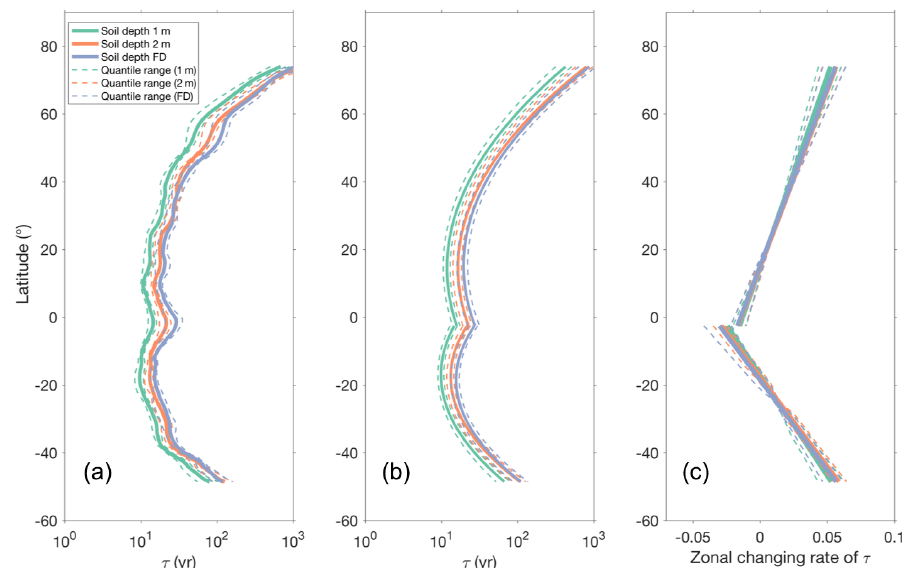
Figure 7. (a) The zonal distribution of τ . (b) Second-degree polynomial fit to the zonal distribution of τ . (c) Zonal rate of changes in τ with latitude (calculated as the first derivative of the polynomial function). Solid lines represent the mean τ for different soil depths (1m, green; 2m, red; full depth, purple), and dashed lines in the corresponding colors are the interquartile range. The polynomial function is fitted independently for the Northern Hemisphere and Southern Hemisphere. The latitude that divides the Northern Hemisphere and Southern Hemisphere is located at 2 ◦ S where there is a local maximum of zonal τ in (a)